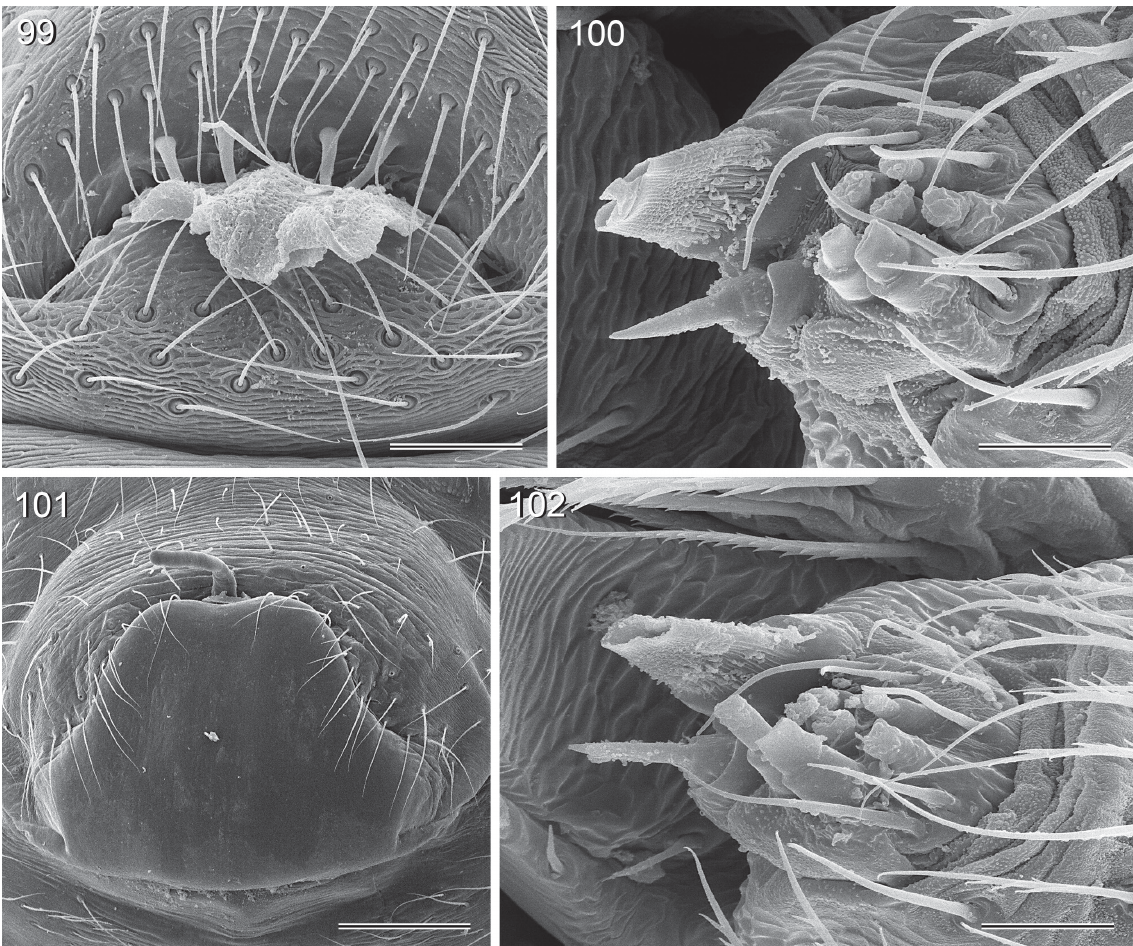
Figs 99–102. Pholcus pagbilao Huber, 2011, ZFMK Ar 15515–16. 99 . Male gonopore. 100 . Male ALS. 101 . epigynum. 102 . Female ALS. Scale lines: 99 = 50 µm; 100, 102 = 20 µm; 101 = 200